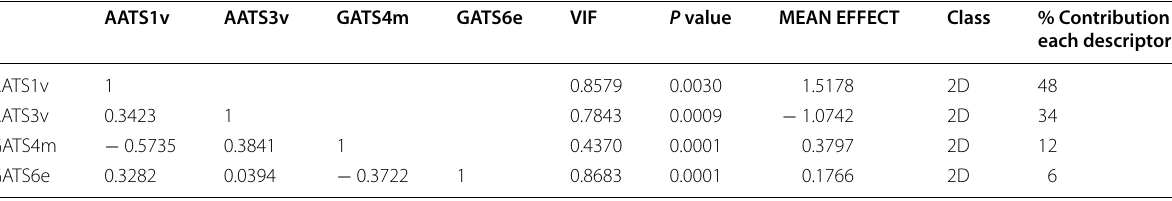
Table 5 Correlation and statistical evaluation assessment of the selected molecular properties